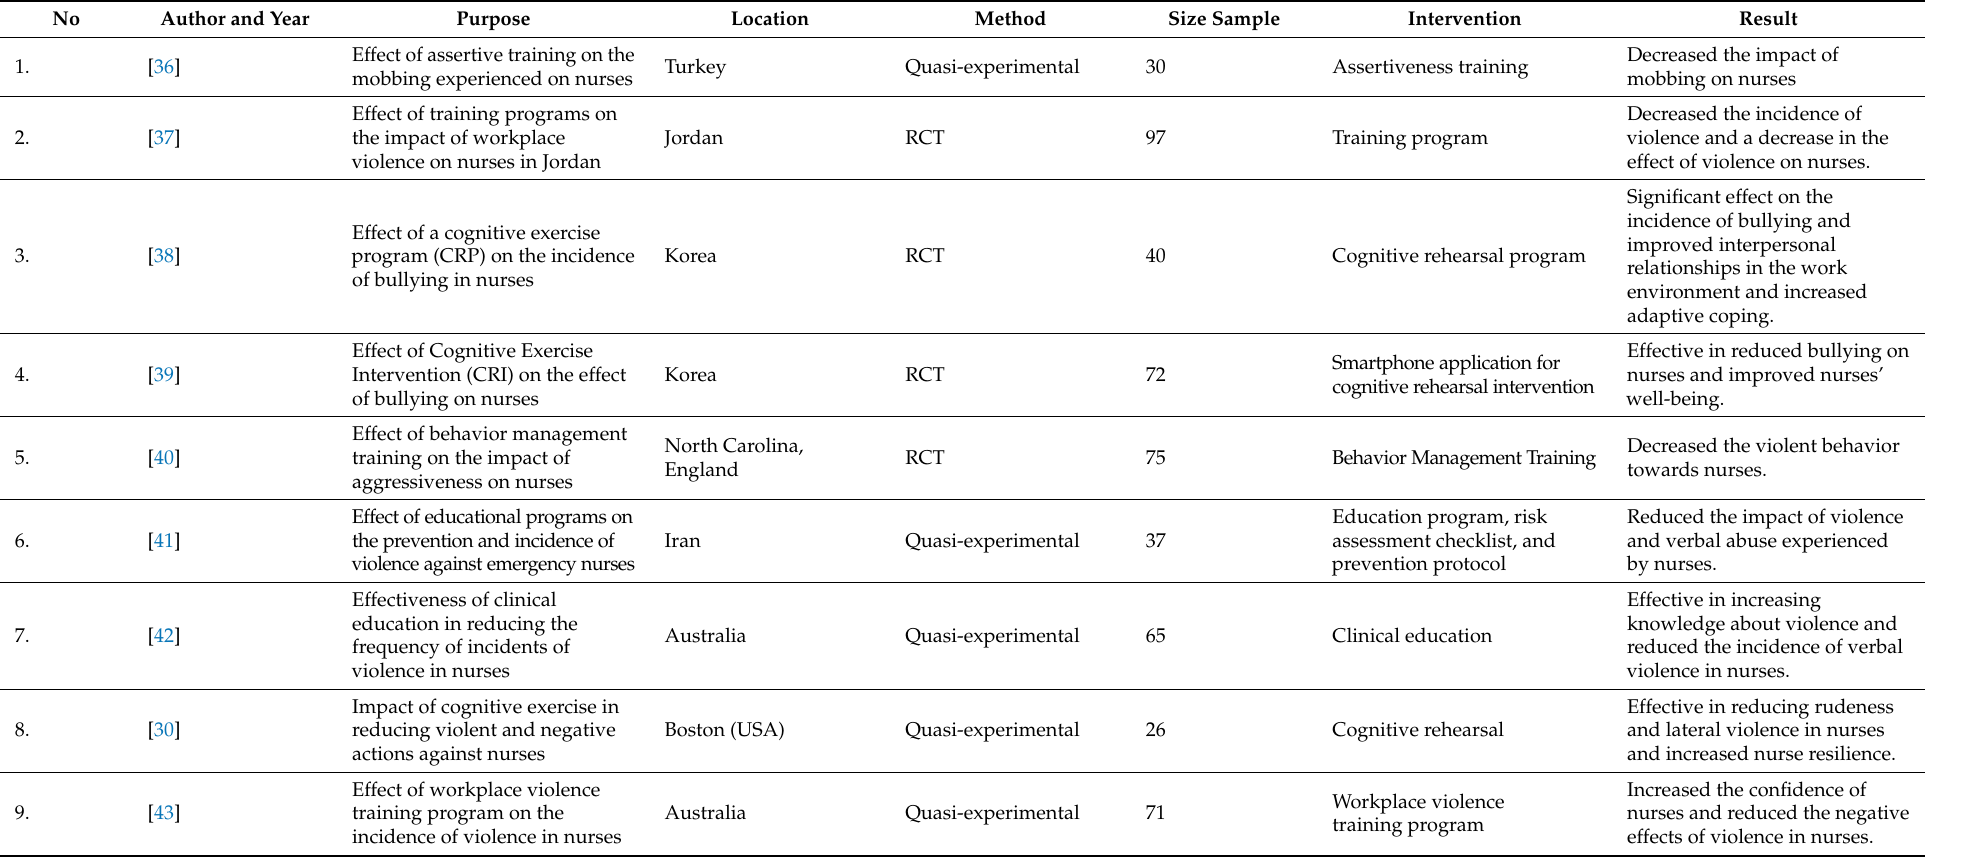
Table 2. Extracted